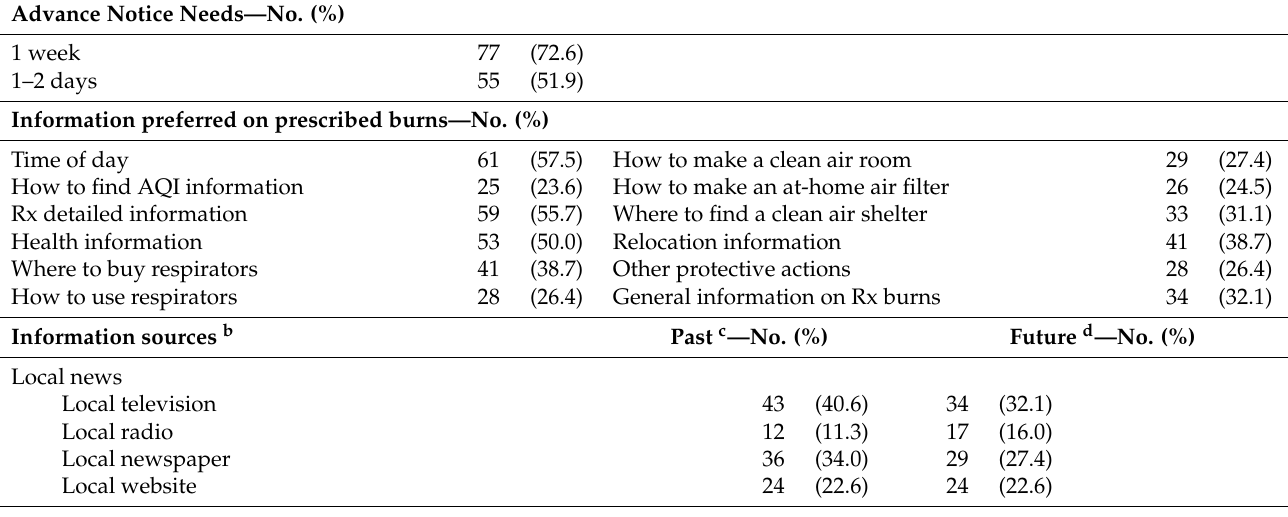
Table 3. Communication and information needs and preferences regarding prescribed fire in a